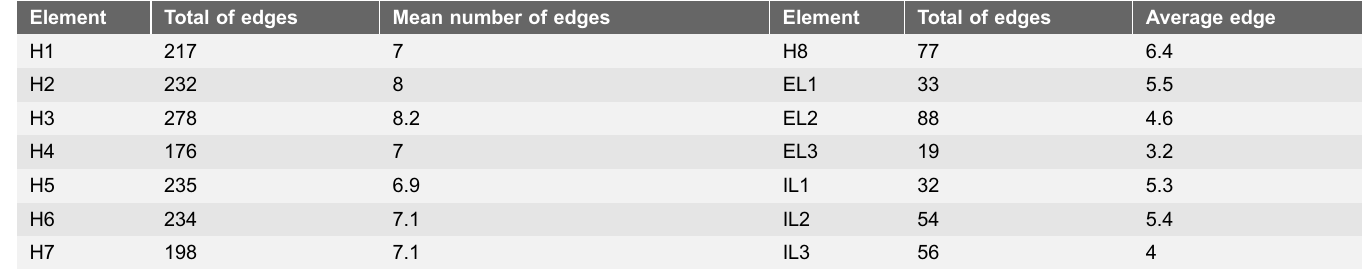
Table 5. Number of edges and its mean value per residue in the residue-residue interaction network determined from the all-atom 0.5 m s MD simulation for the helices, ILs, and ELs of the m OR structure.